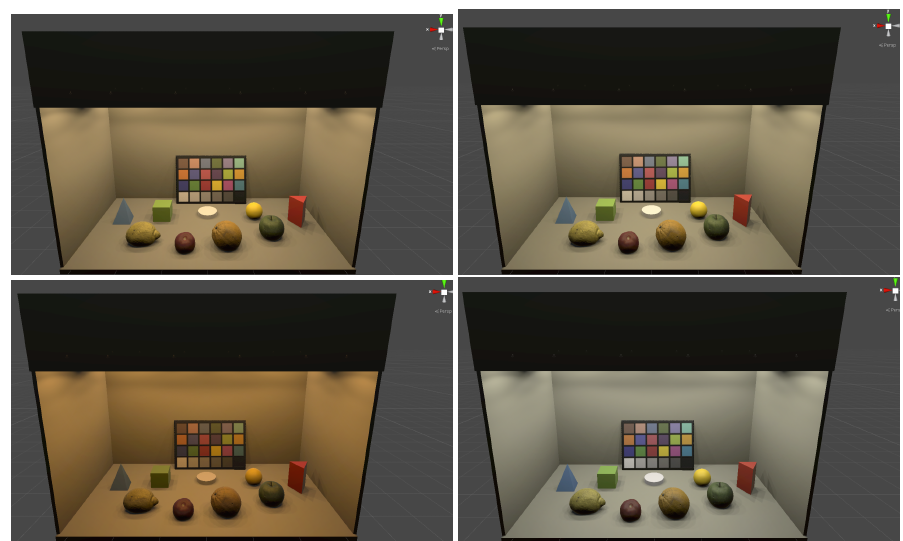
Figure 8. Screenshots of the final virtual scenarios using hyperspectral information and different light sources. TL84 ( top left ), D50 ( top right ), A ( bottom left ) and D65 ( bottom right ).